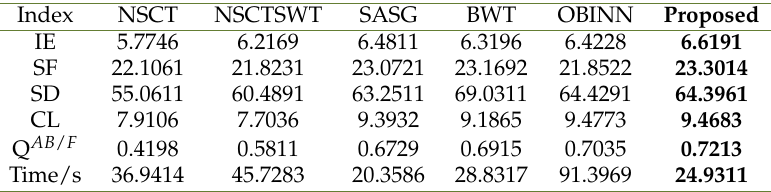
Table 1. The mean values of objective evaluation indexes of the three